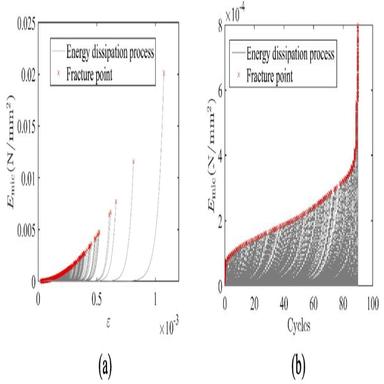
The simulated energy dissipation processes of tensile micro-springs (a) Monotonic loading (b) Fatigue loading. Adapted from.